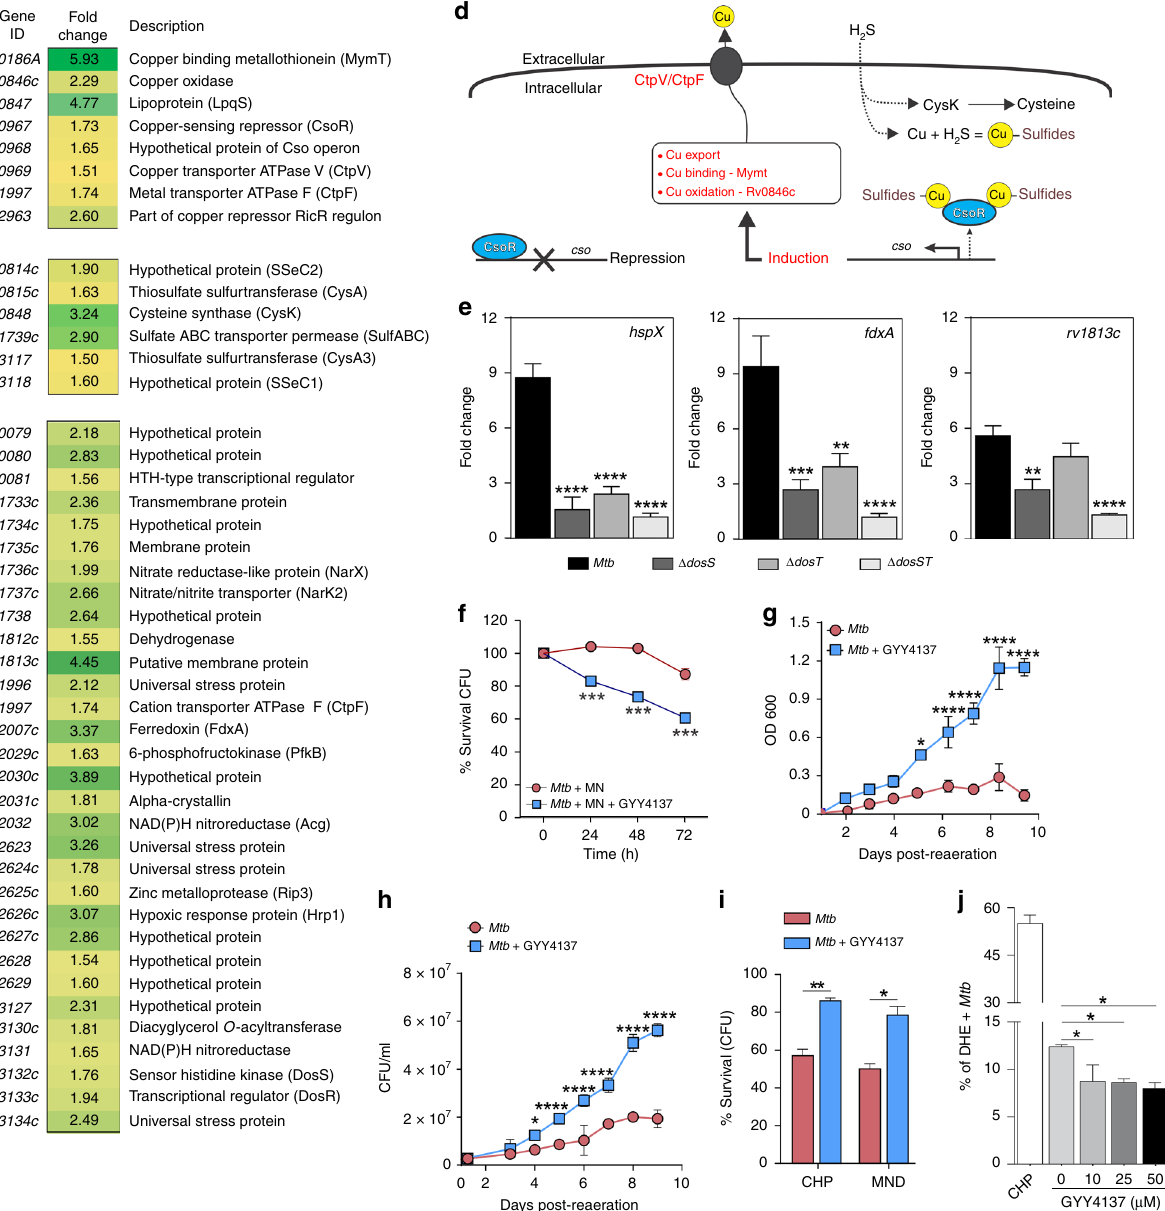
Fig. 5 H 2 S induces transcriptome remodeling and mitigates oxidative stress in Mtb . RNA-seq-based gene expression analysis shows induction of